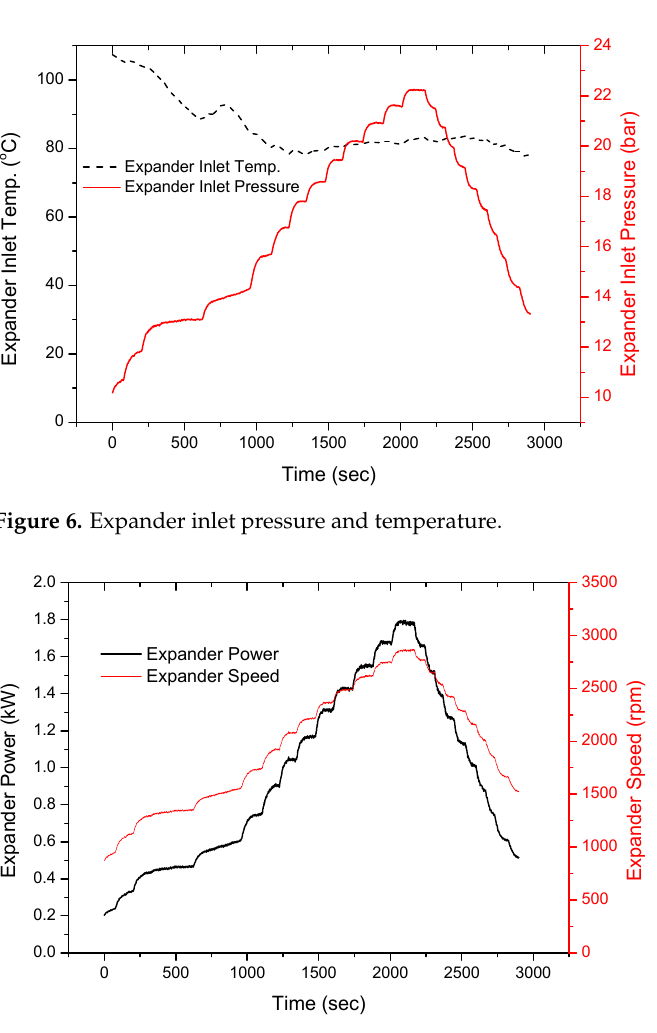
Figure 8. Temperature decrease of the exhaust gas.